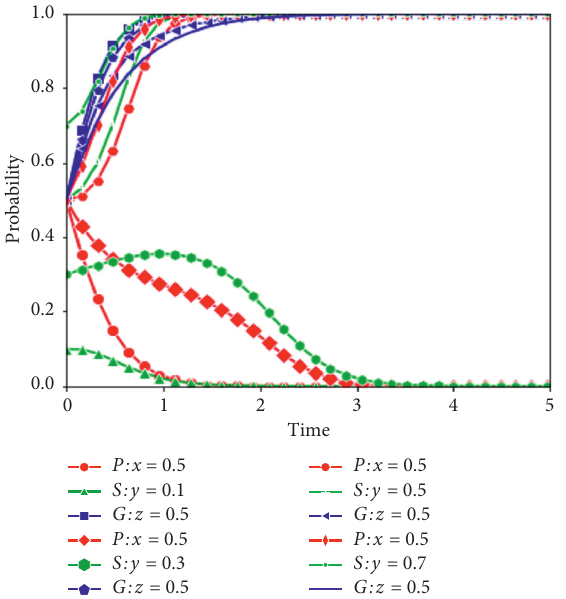
Figure 3: Dynamic evolution process of the tripartite game sub- jects when y changes.